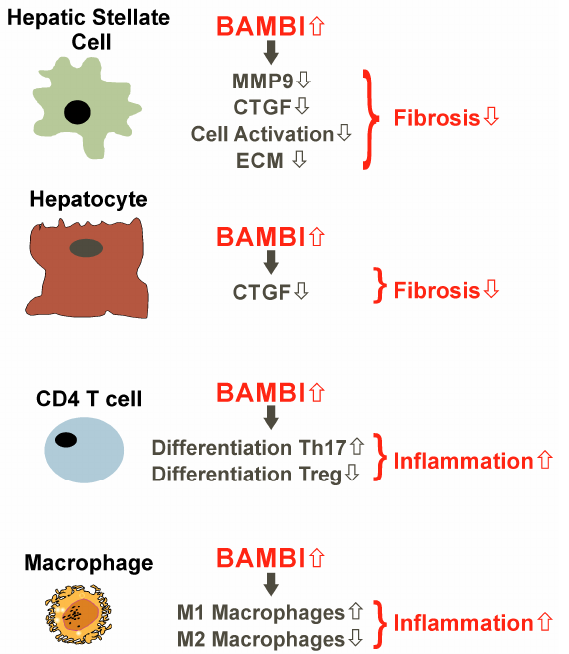
Figure 3. Effect of BAMBI overexpression in hepatic stellate cells (HSCs), hepatocytes, T cells and macrophages. In HSCs, BAMBI overexpression reduces cell activation, matrix metalloproteinase 9 (MMP9), connective tissue growth factor (CTGF), and extracellular matrix (ECM) protein expression. CTGF protein is also low in hepatocytes with high BAMBI levels. These effects of BAMBI protect from organ fibrosis. High BAMBI shifts T cell differentiation from regulatory (Treg) to Th17 cells and promotes the expression of M1 markers in macrophages, and both effects contribute to inflammation. ulated immune response in the liver, and may contribute to hepatic inflammation